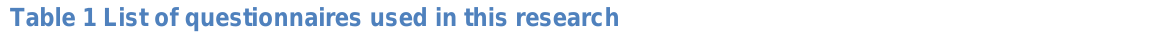
Table 1 List of questionnaires used in this